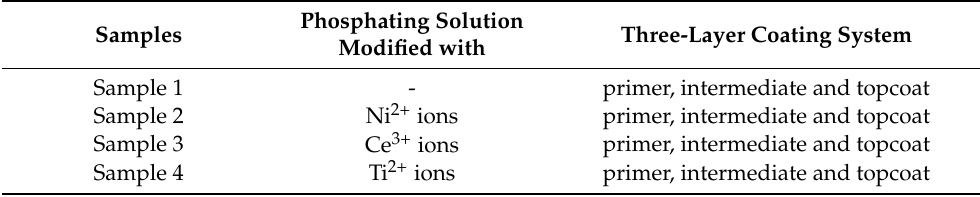
Table 4. Modified phosphatized samples protected by the coating